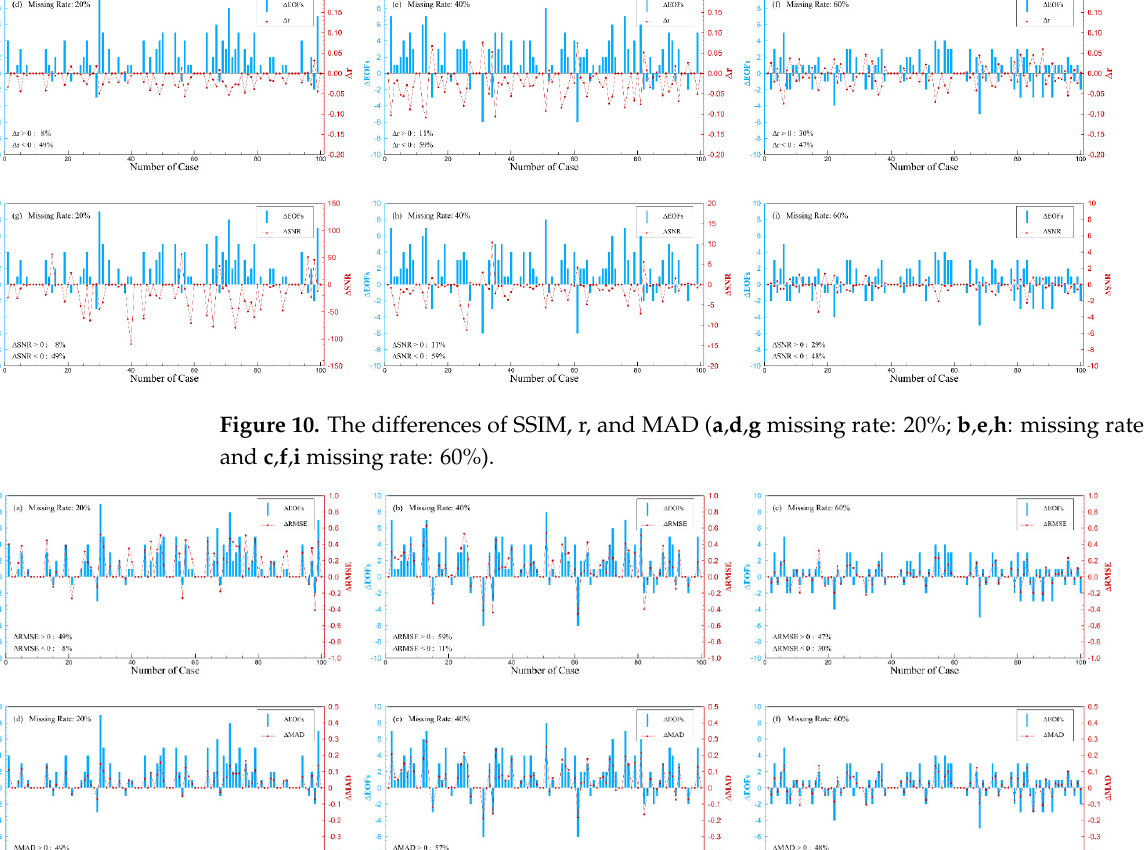
Figure 10. The differences of SSIM, r, and MAD ( a , d , g missing rate: 20%; b , e , h : missing rate: 40%; and c , f , i missing rate: 60%).